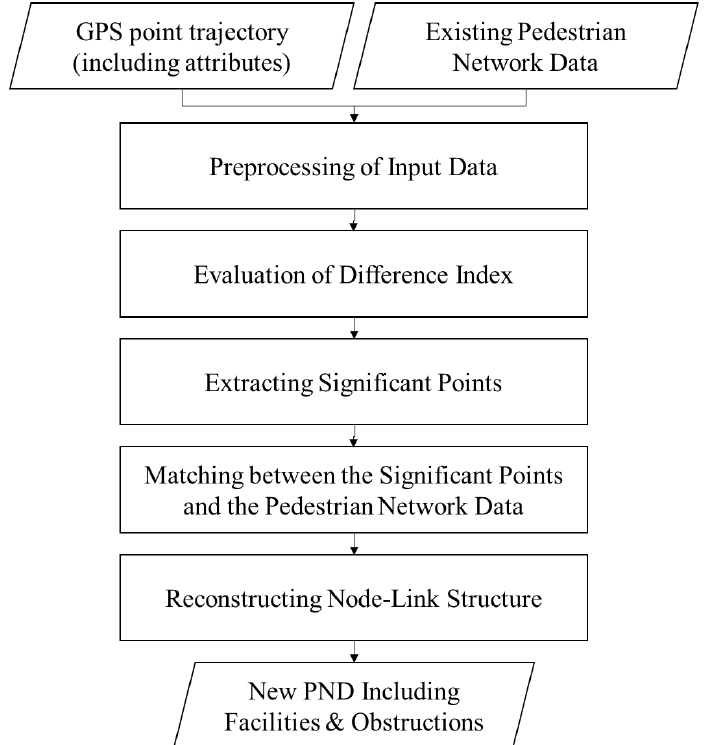
Figure 1. Flowchart of the process to construct the pedestrian network data (PND) for transport of vulnerable